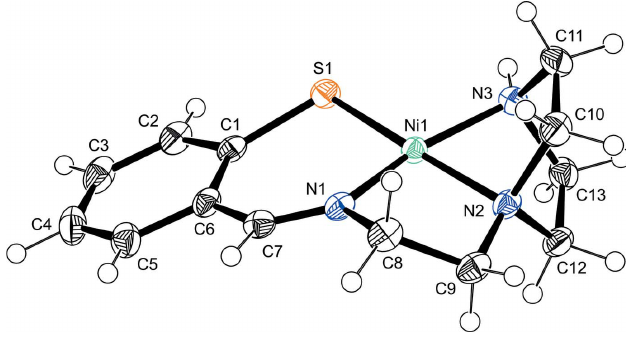
Figure 2 Perspective view of the complex cation of 2 with displacement ellipsoids at the 50% probability level.